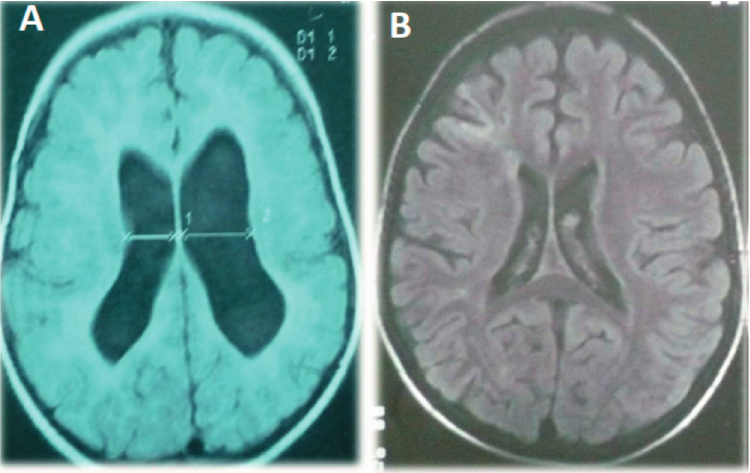
Figure 1. Magnetic resonance image of patient 2 ( A ) and 3 ( B ) showing an increase in lateral cerebral ventricle volume, diffuse enlargement of the cortical spaces, and cortical